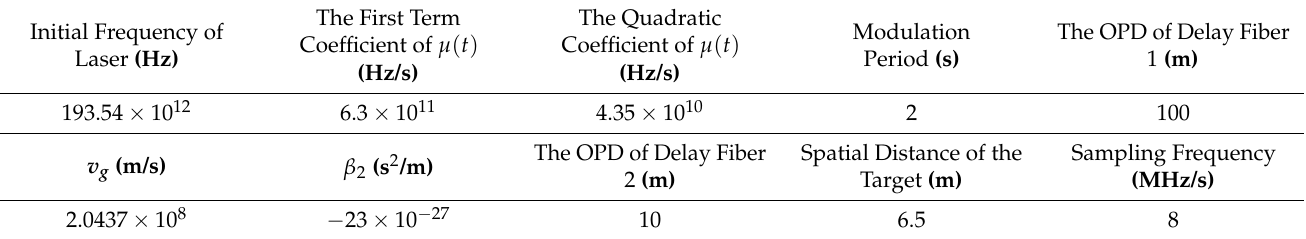
Table 1. Simulation parameters setting.